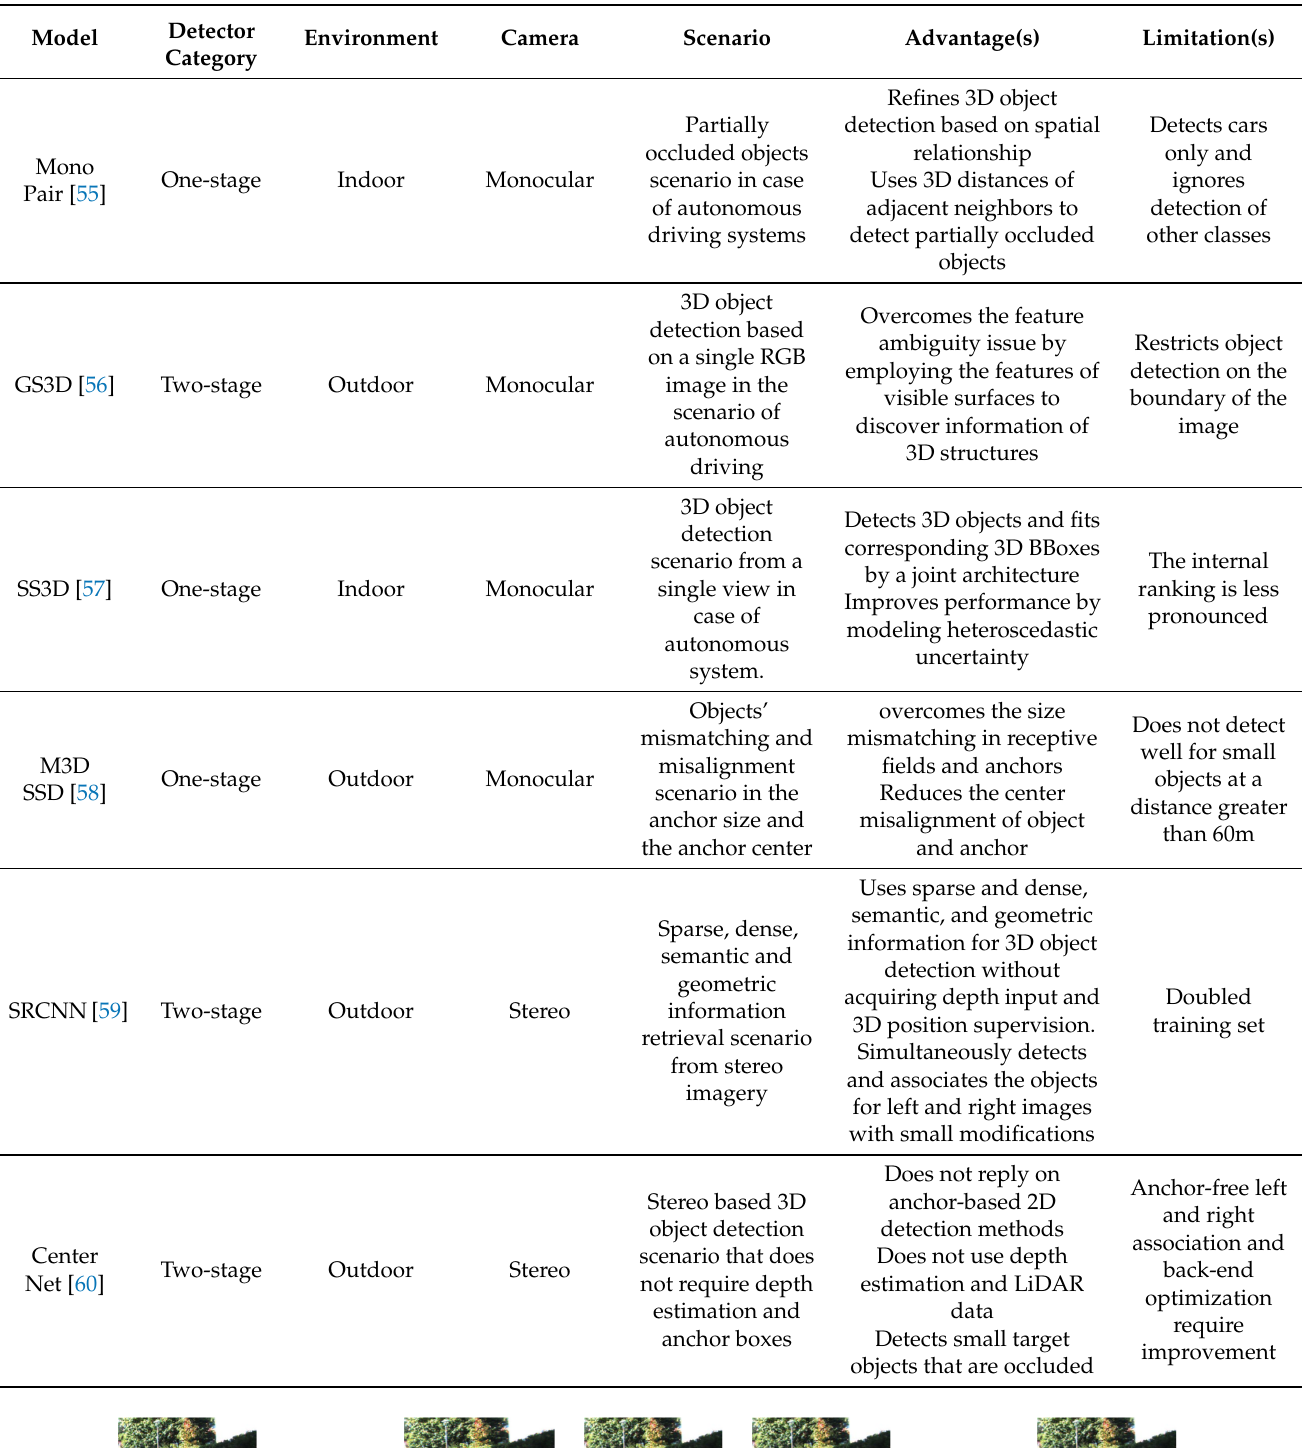
Table 9. Literature Analysis: Camera-based 3D Object Detection Methods.